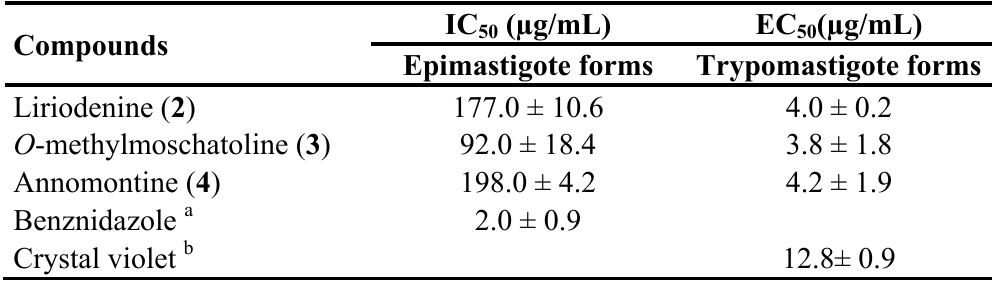
Table 1. Trypanocidal activity of the oxoaporphine and pyrimidine-  -carboline alkaloids ( 2 – 4